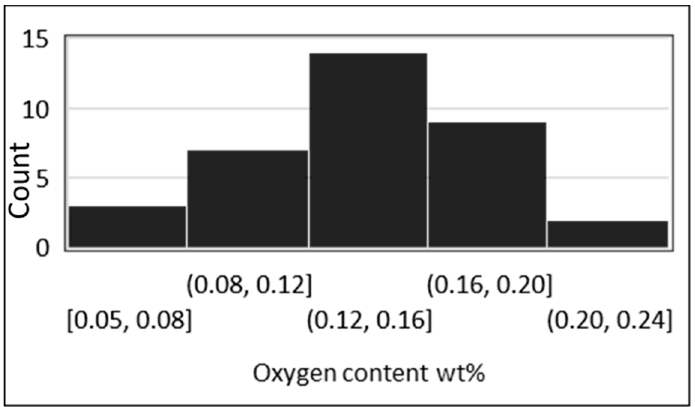
Figure 21. Distribution of typical oxygen content for grade 2 wrought product (ASTM maximum is 0.25 wt %). Sample size = 35 sources.